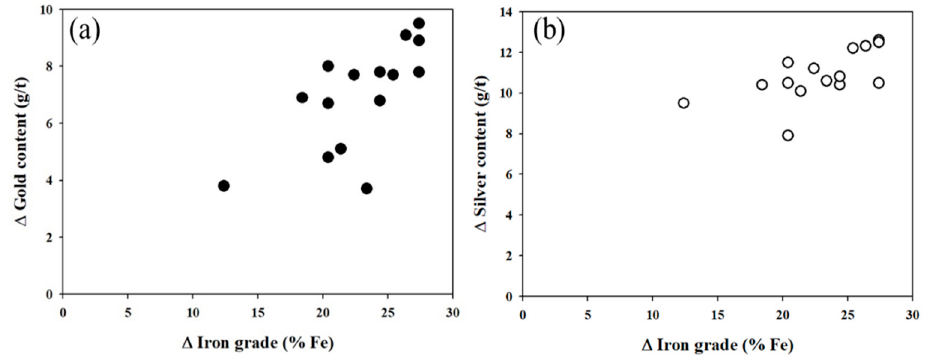
Figure 8. ( a ) Increases ( ∆ ) of gold contents and ( b ) silver contents during the increase of iron grade in RMR-MS processed concentrates. All data obtained in the overall RMR-MS tests in this study was plotted. (Raw ore sample contained 6.4 and 35.6 g/t of gold and silver and 28.6% of iron).